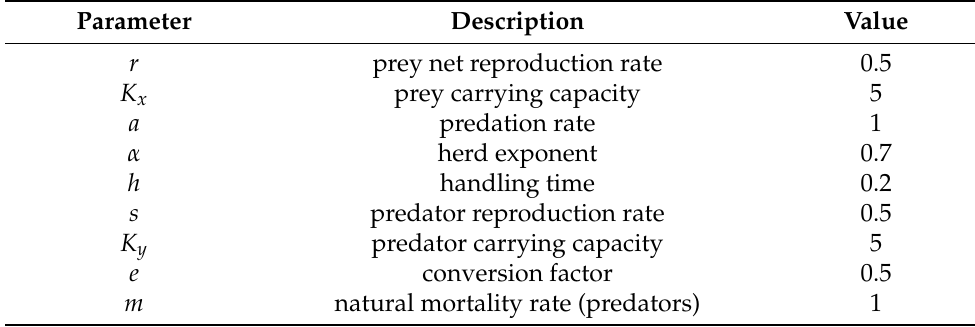
Table 9. Nominal set of parameter values for the third model (42) and